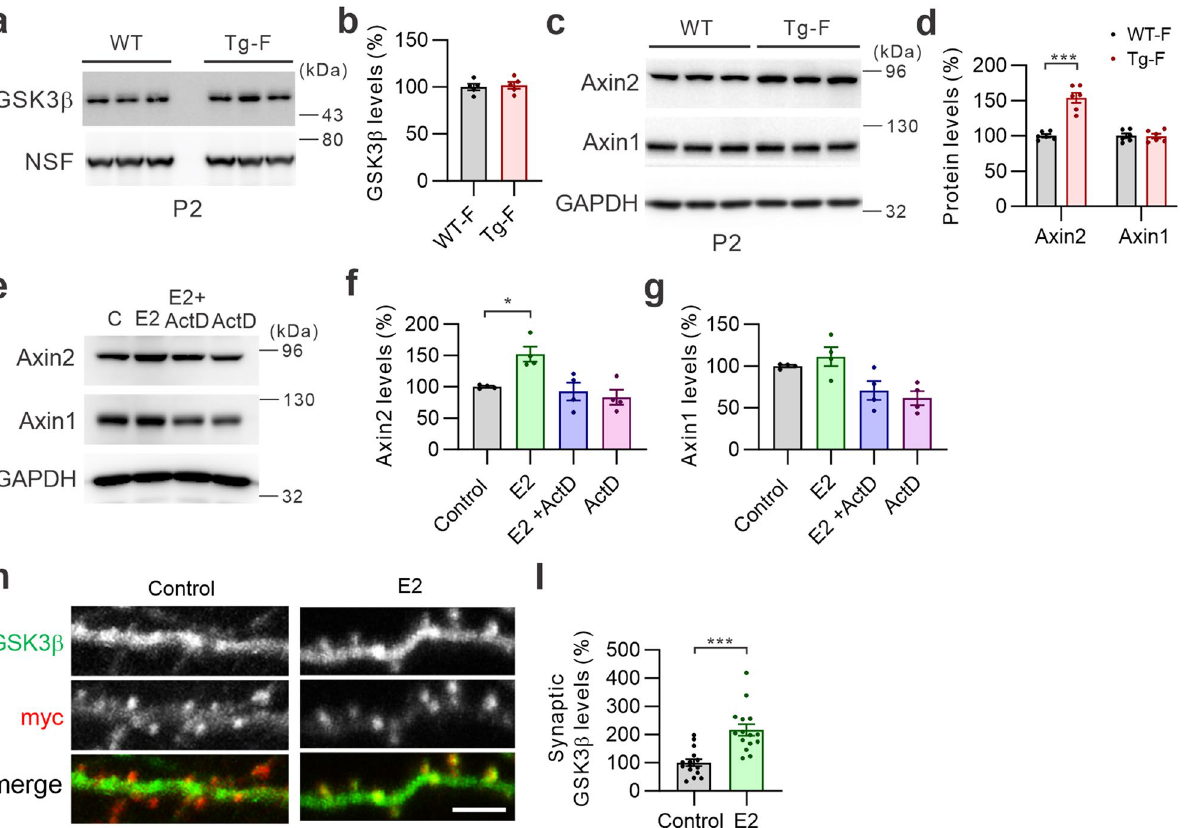
Figure 5. Sex-specific reduction of synaptic GSK3β is mediated by estradiol-mediated increase of Axin2. ( a , b ) Female S-SCAM Tg mice have normal synaptosomal GSK3β protein levels. Representative images ( a ) and quantification of GSK3β levels in the P2 fraction ( b ). n = 5 per group. ( c , d ) Increased Axin2 protein levels in the P2 fraction of female S-SCAM Tg mice. Representative images ( c ) and quantification of Axin1 and Axin2 levels in the P2 fraction ( d ). n = 6 per group. *** p < 0.0001, unpaired t -test with Welch’s correction. ( e – g ) E2 (10 nM) increases Axin2 protein levels in cultured hippocampal neurons. Representative images ( e ) and